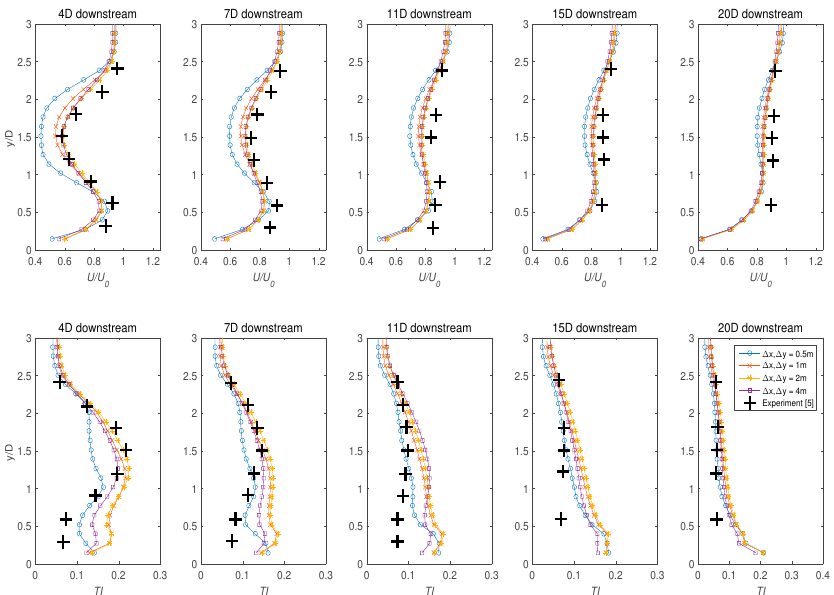
Figure 7. The influence of the structured grid density, ( ∆ x & ∆ y ) on the flow at increasing distances downstream of the turbine. The vertical resolution, ∆ z , and the disc thickness, ∆ x t , were maintained at 24 sigma layers and 2 m, respectively for all cases.